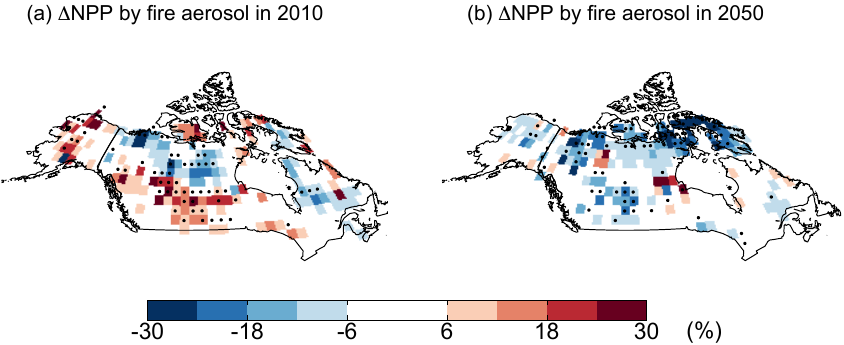
Figure 12. Predicted percentage changes in summer NPP caused by wildfire aerosols at (a) present day and (b) mid-century. Results for the 2010s are calculated as (F10AERO/F10CTRL-1) · 100%. Results for the 2050s are calculated as (F50AERO/F50CTRL-1) · 100%. Signifi- cant changes ( p < 0 . 05) are marked with black